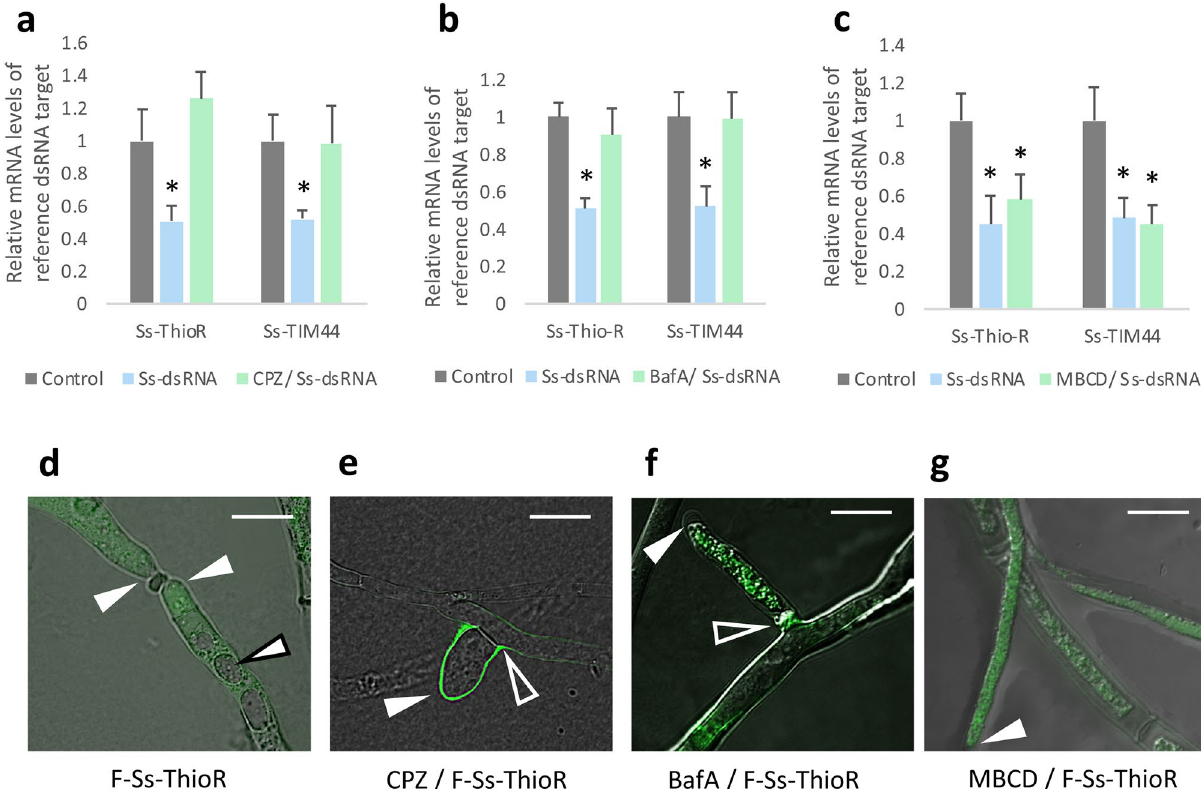
Figure 2. Chemical inhibition of clathrin mediated endocytosis inhibits dsRNA uptake. ( a ) In vitro cultures were inoculated with 20 µM chlorpromazine (CPZ), ( b ) 0.2 µM bafilomycin A1 (BafA), or ( c ) 2 mM methyl- beta-cyclodextrin (MBCD). Two hours later, hyphae were treated with 500 ng/mL Ss-ThioR or Ss-TIM44 dsRNA and transcript levels of these two genes were measured two days later. Asterisk denote significantly different values relative to the negative control (one-tailed t-test, p < 0.05, from three independent biological replicates). ( d – g ) Confocal microscopy reveals distribution of fluorescein-labelled dsRNA in hyphae, 4 h post- treatment, treated with or without inhibitors. ( d ) No inhibitors, ( e ) 20 µM CPZ, ( f ) 0.2 µM BafA, or ( g ) 2 mM MBCD. Cultures were imaged three separate times with similar results. (White arrow with black border: fungal vacuole; White arrow with no border: hyphal tip; Hollow arrow with white border: branch point of a hyphal bud). (Scale bars: 10